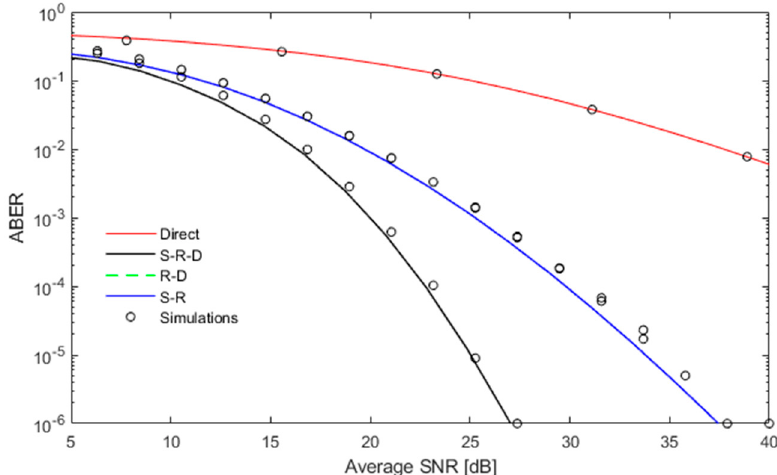
Figure 11. ABER vs. SNR of FSO over G ‐ G channel for strong turbulence with distance 500–500 m, the number of relays =3, and w z = 2 m.